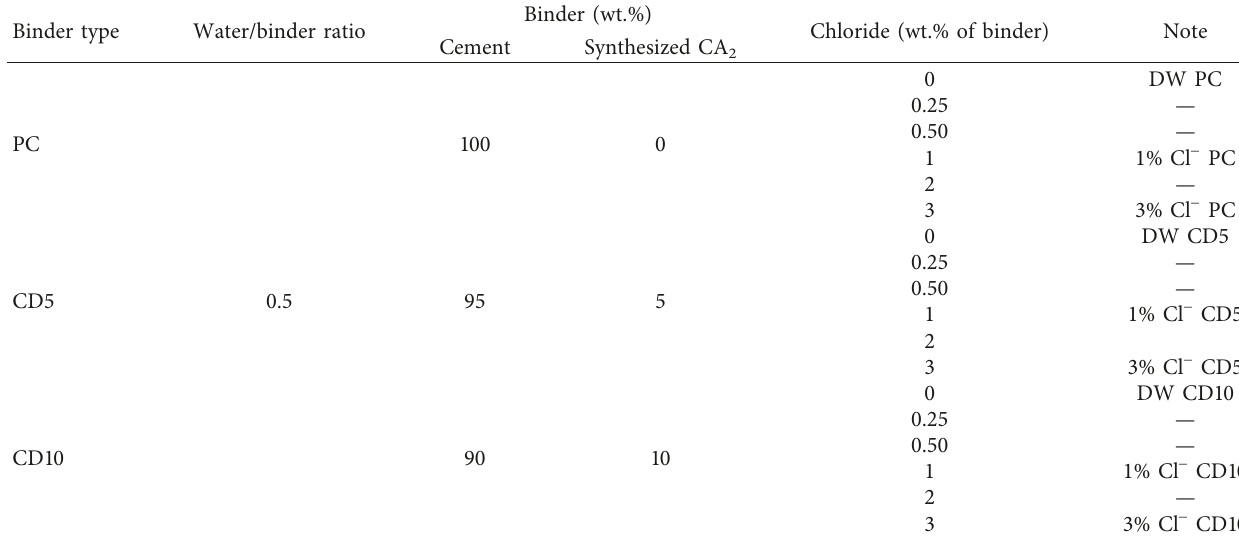
Table 2: Mix proportion of cement paste.